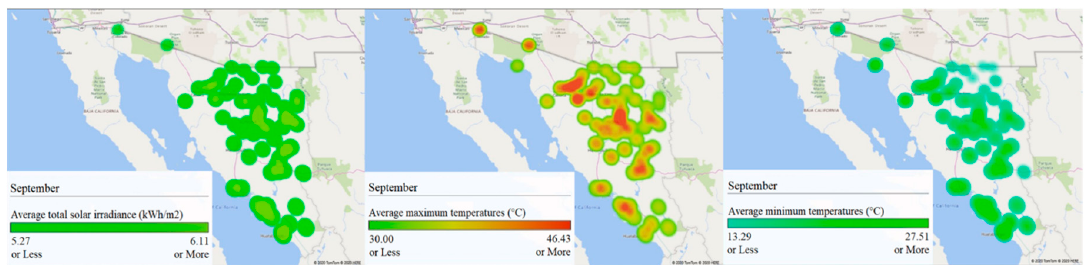
Figure 15. GIS analysis of Sonora for September: ( left ) average total solar irradiance (kWh/m 2 ), (center) maximum average temperatures (°C), and ( right ) minimum average temperatures (°C).